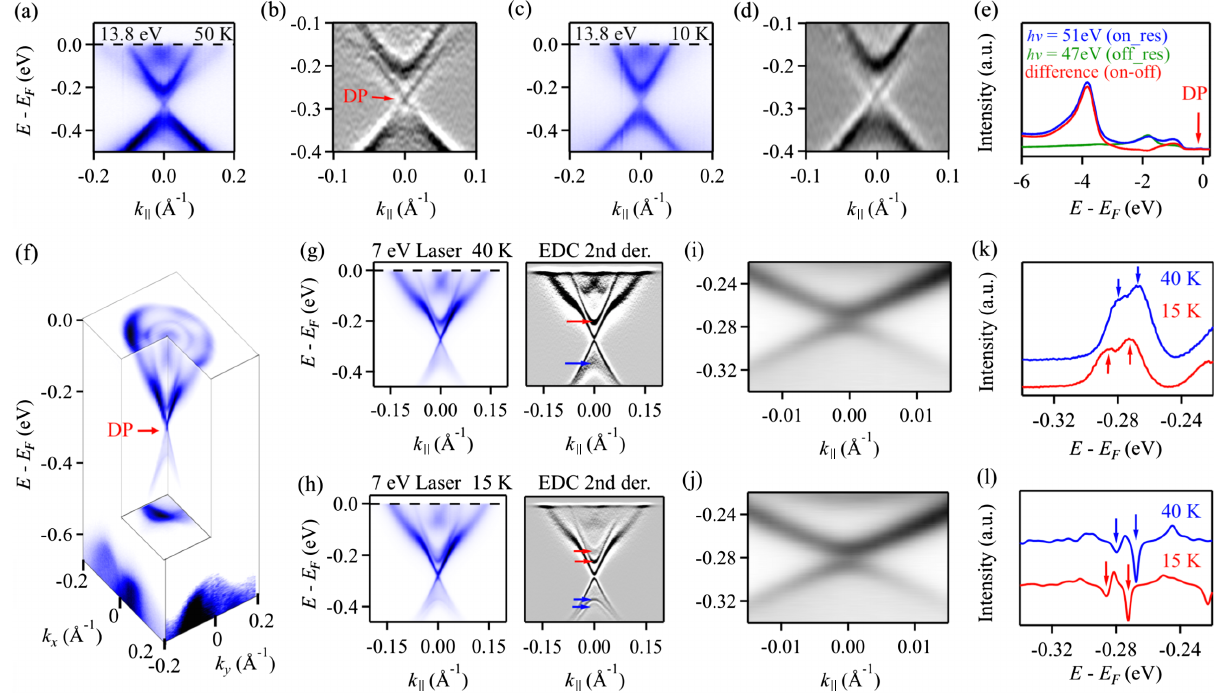
¯ Γ taken at h ν ¼ 13 . 8 eV at ¯ Γ taken ¯ Γ at 40 and 15 K.